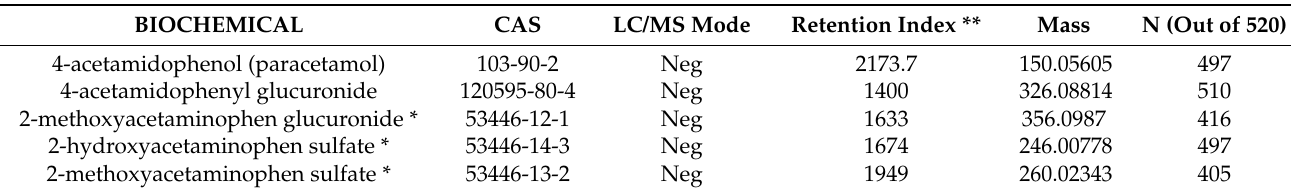
Table 1. Nine acetaminophen metabolites detected in